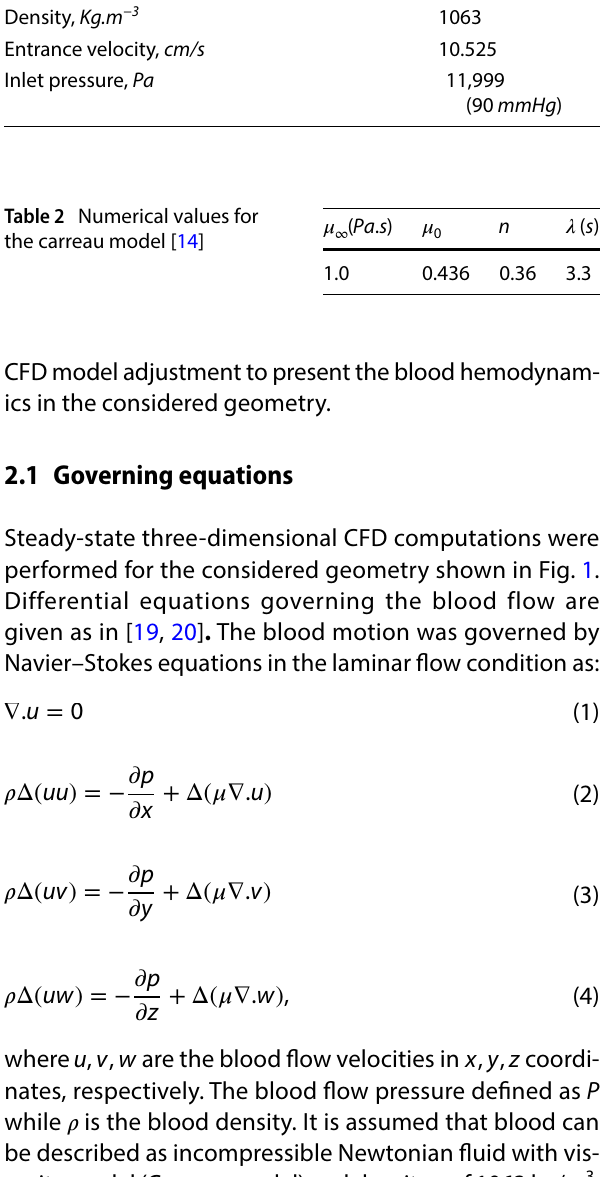
Table 1 Blood flow properties used for the straight cylindrical ves- sel with an idealized stenosis Properties